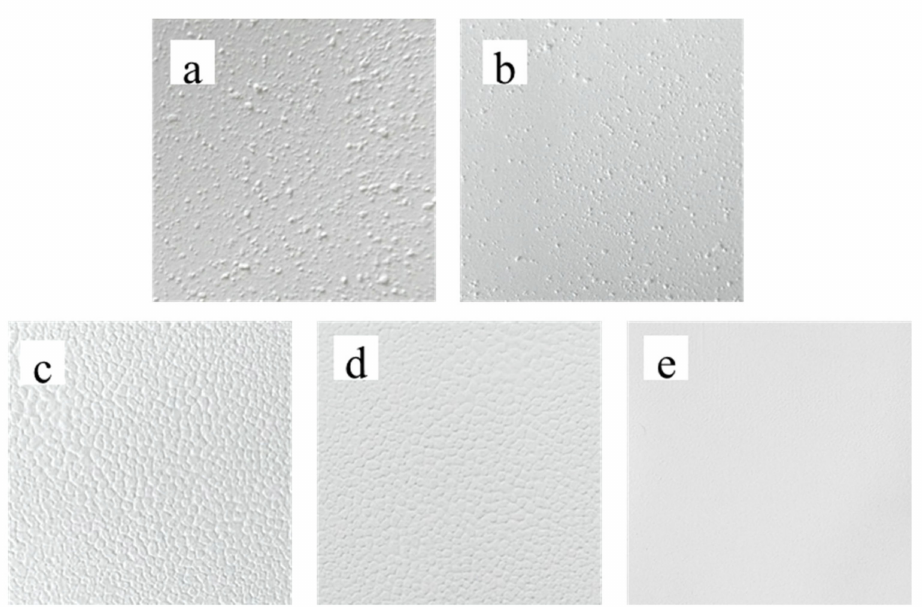
Figure 5. TiO 2 bifunctional sheets prepared at di ff erent times: ( a ) 30 min; ( b ) 2 h; ( c ) 3 h; ( d ) 4 h; ( e ) 5 h. To investigate the dispersion e ff ect of the TiO 2 bifunctional sheets, 10 µ L serum was added to sheets prepared at di ff erent mixing times of 30 min, 2 h, 3 h, 4 h, and 5 h, respectively. As shown in Figure 6, after 10 s of di ff usion, the serum could hardly di ff use on the surface of the 30 min-stirred sheets. The di ff usion ability of the TiO 2 sheets prepared with 2 h stirring was slightly improved. The residual liquid on the surface decreased, but the di ff usion e ff ect was still not ideal. The serum di ff used fast without any residue on the surface of sheets prepared with 5 h stirring.